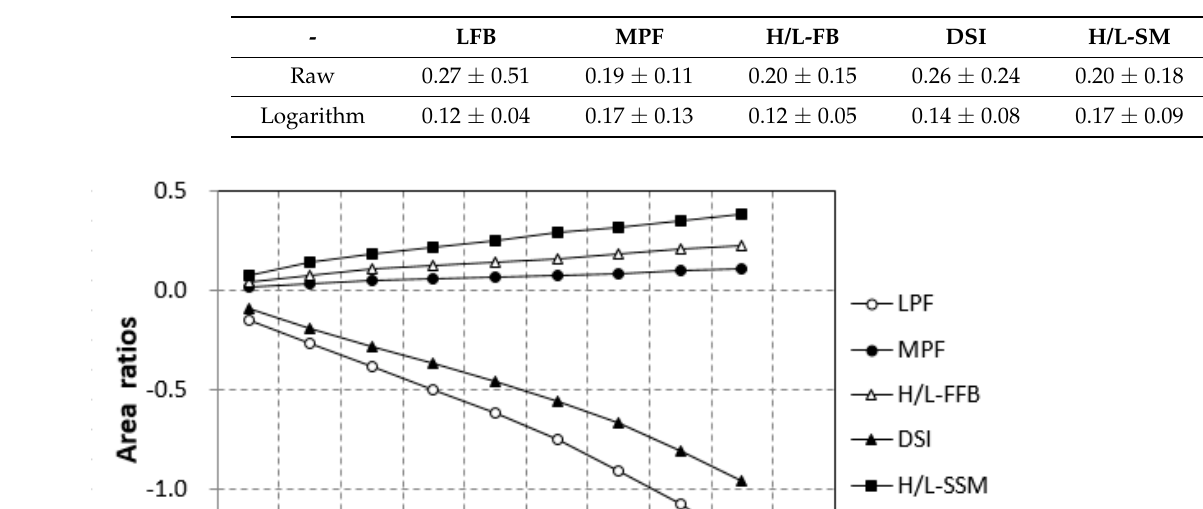
Table 2. Mean and standard deviation of coefficient of variation (CV) of all parameters.